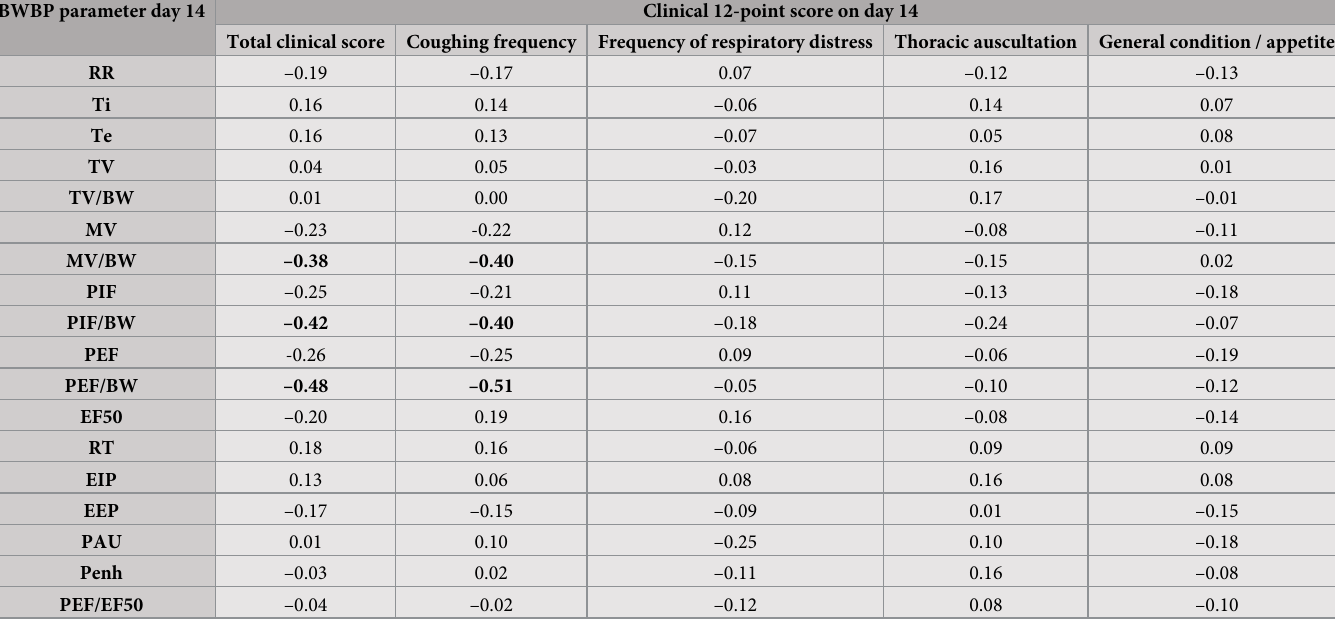
Table 7. Correlation coefficients r between the clinical 12-point score and the individual BWBP parameters on day 14. BWBP parameter day